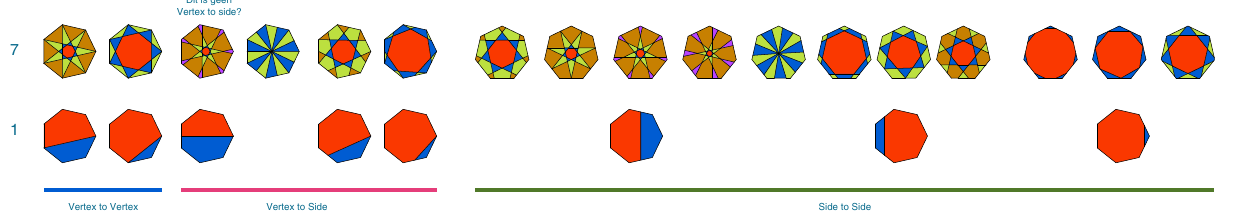
Figure n7A. Heptagons ( m = 7).